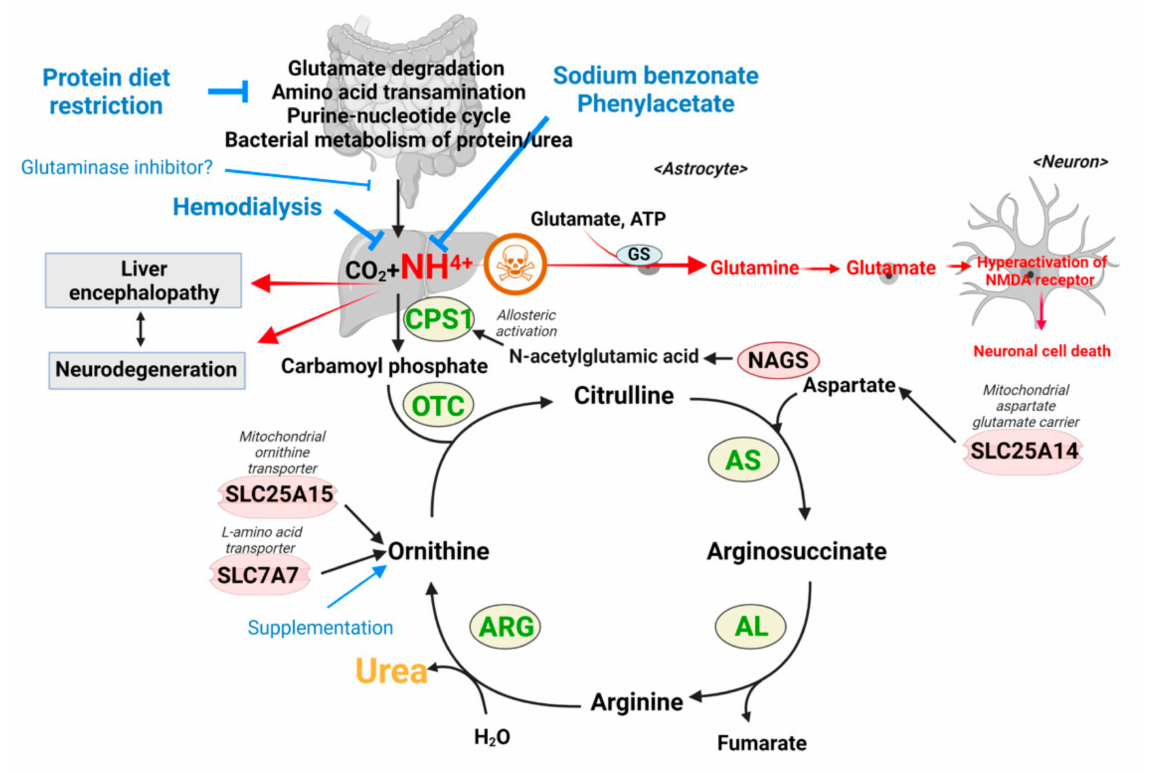
Figure 3. Schematic diagram of urea cycle that detoxifies ammonia, toxicity mechanism of ammonia, and therapeutic options for hyperammonemia. Ammonia is produced throughout the cells of the body in numerous metabolic processes such as transamination reactions, glutamate degradation, and nucleotide metabolism. These systemic levels of ammonia are cleared by the urea cycle in the liver so that the nitrogen is ultimately excreted in the form of urea. Impairing mutations in the urea cycle enzymes leads to an inability to clear ammonia, leading to the disorder of hyperammonemia. Dysfunction of the liver, such as due to cirrhosis, can similarly lead to secondary hyperammonemia. In these contexts, the prevailing model is that ammonia is used to produce high levels of glutamine in astrocytes, causing their swelling, and also leading to glutamate formation in neurons to trigger excitotoxicity. Current strategies involve protein restriction to decrease ammonia formation, sodium benzonate and phenylacetate treatment to ‘chelate’ ammonia, or supplementation to activate the urea cycle. GS: glutamine synthase; CPS1: carbamoyl phosphate synthetase; OTC: ornithine transcarbamy- lase; AS: argininosuccinate synthetase; AL: argininosuccinic acid lyase AL; ARG: arginase;